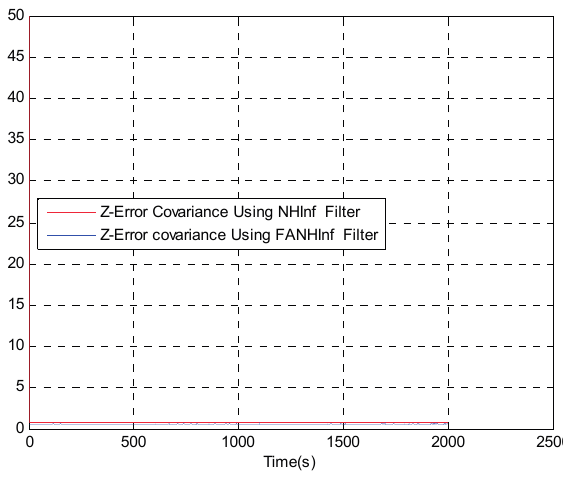
Figure 13. Error covariance in z -axes.